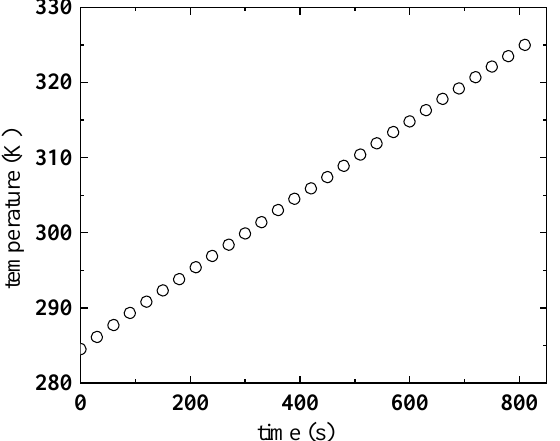
Figure 8. Record of the temperature rise of the water bath.